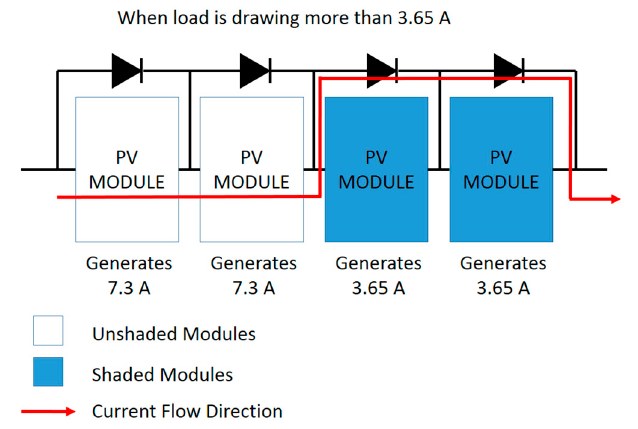
Figure 15. When the load is drawing more than 3.65 A.